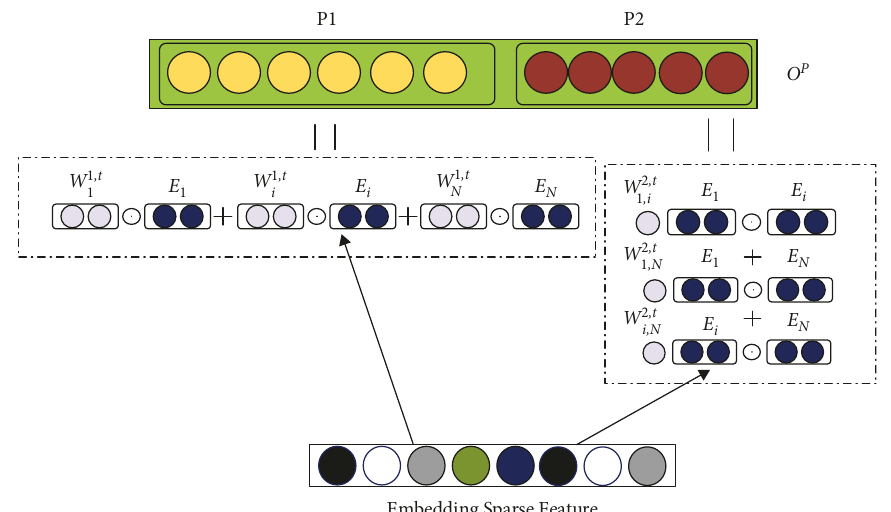
Figure 4: The structure of product layer in Double Cross Net.